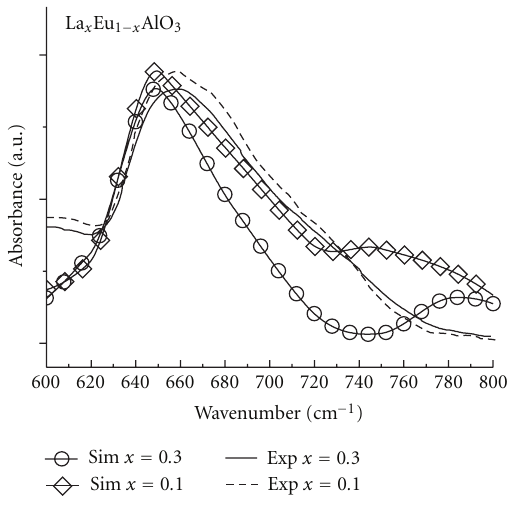
Figure 1: Infrared spectra, simulated and experimental, of per- ovskite samples with variable content of